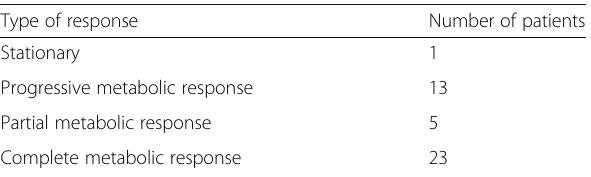
Table 3 Treatment response of patients according to Lugano classification